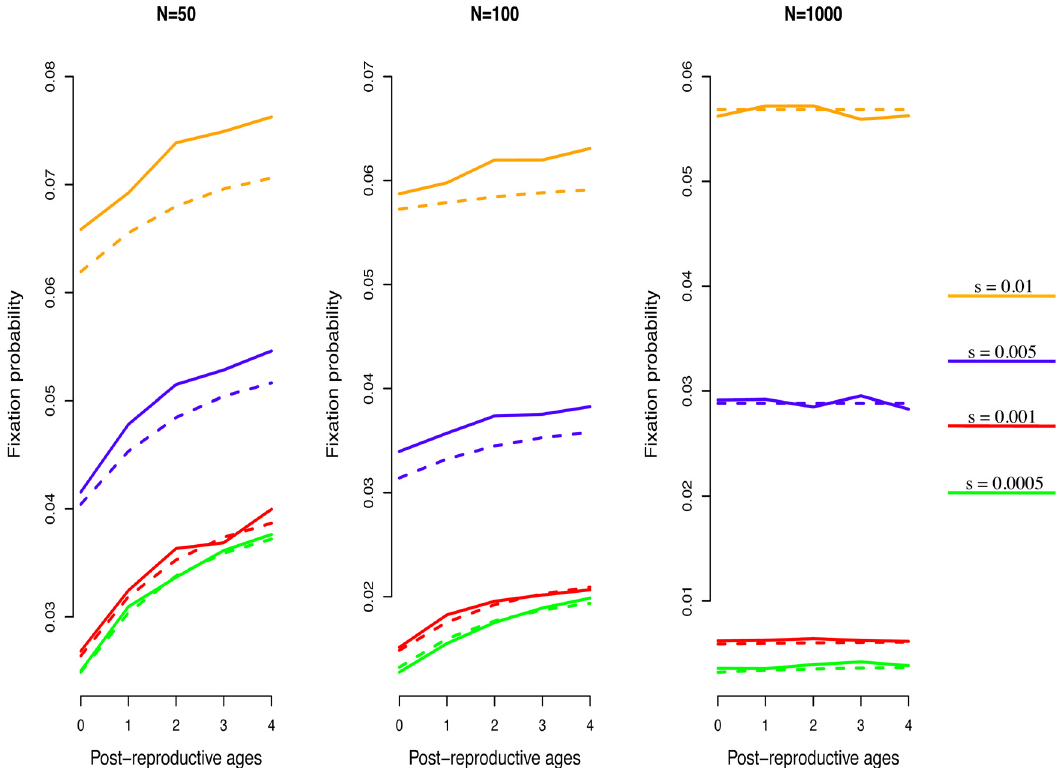
Fig 1. Fixation probability as a function of post-reproductive lifespan. A density-independent, stationary, closed-to-migration population of size N was initiated with a single mutant with advantage s in the first age class. At each simulation step, all individuals in age classes smaller than or equal to 2 produce exactly one newborn each. Individuals in the maximum age class (i.e. 2 + post-reproductive ages) are removed from the population. Resident and mutant individuals survive to the next age class with probability 0.618034, but while resident newborns enter the first age class with the same probability, mutant newborns do so with probability 0.618034 + f (s), where f (s) > 0 is such that the mutant growth rate is equal to s plus the resident growth rate. The simulation run ended with population extinction or fixation of one of the two types. The population was considered extinct when there was no individual with reproductive value. Fixation for one type was considered achieved when the total reproductive value in the population was exclusively contributed to by that type ’ s subpopulation. Fixation probability of the mutant was calculated as the number of times it achieved fixation in 100000 simulation runs without considering those runs in which the whole population went extinct before fixation of either type. We compared simulation results (solid line) with analytic results (dashed line) derived from the approximation in Eq (4) in the main text. We explored the role of increasing the maximum attainable age, the total population size, and the magnitude of the advantageous effect of the